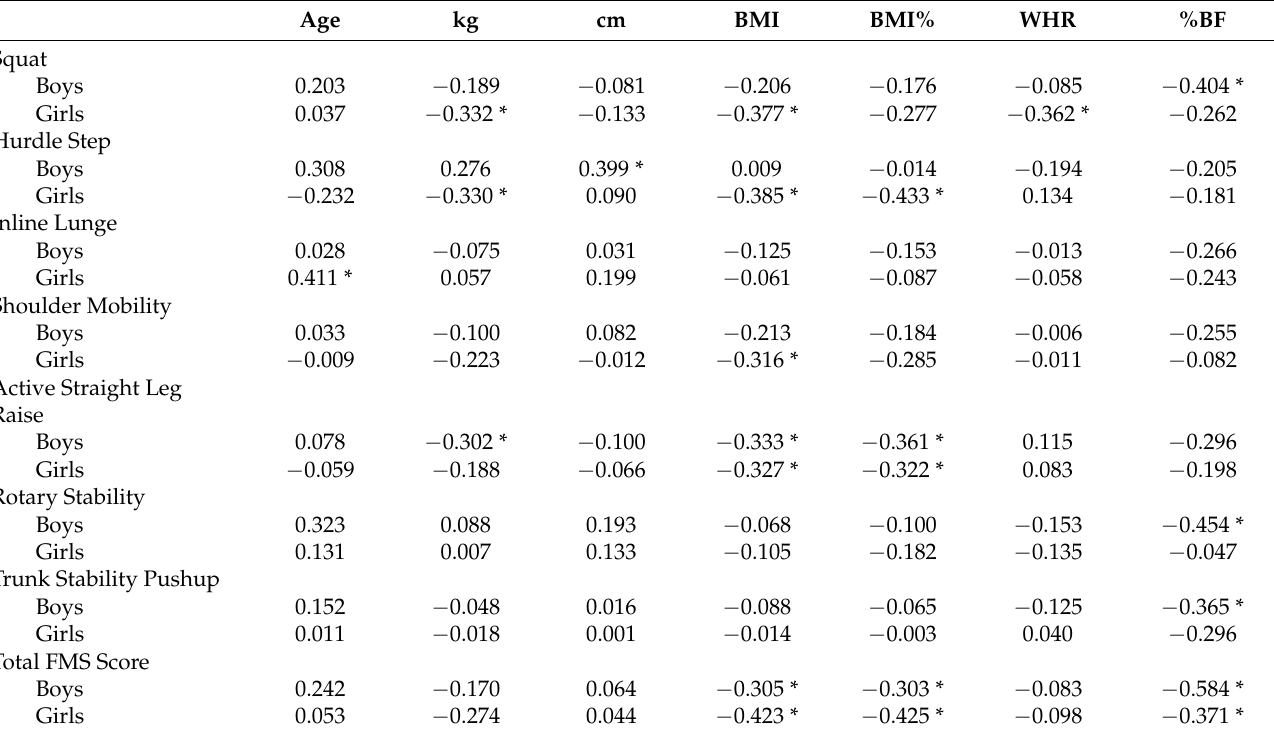
Table 5. Correlation matrix between anthropometric measures and FMS